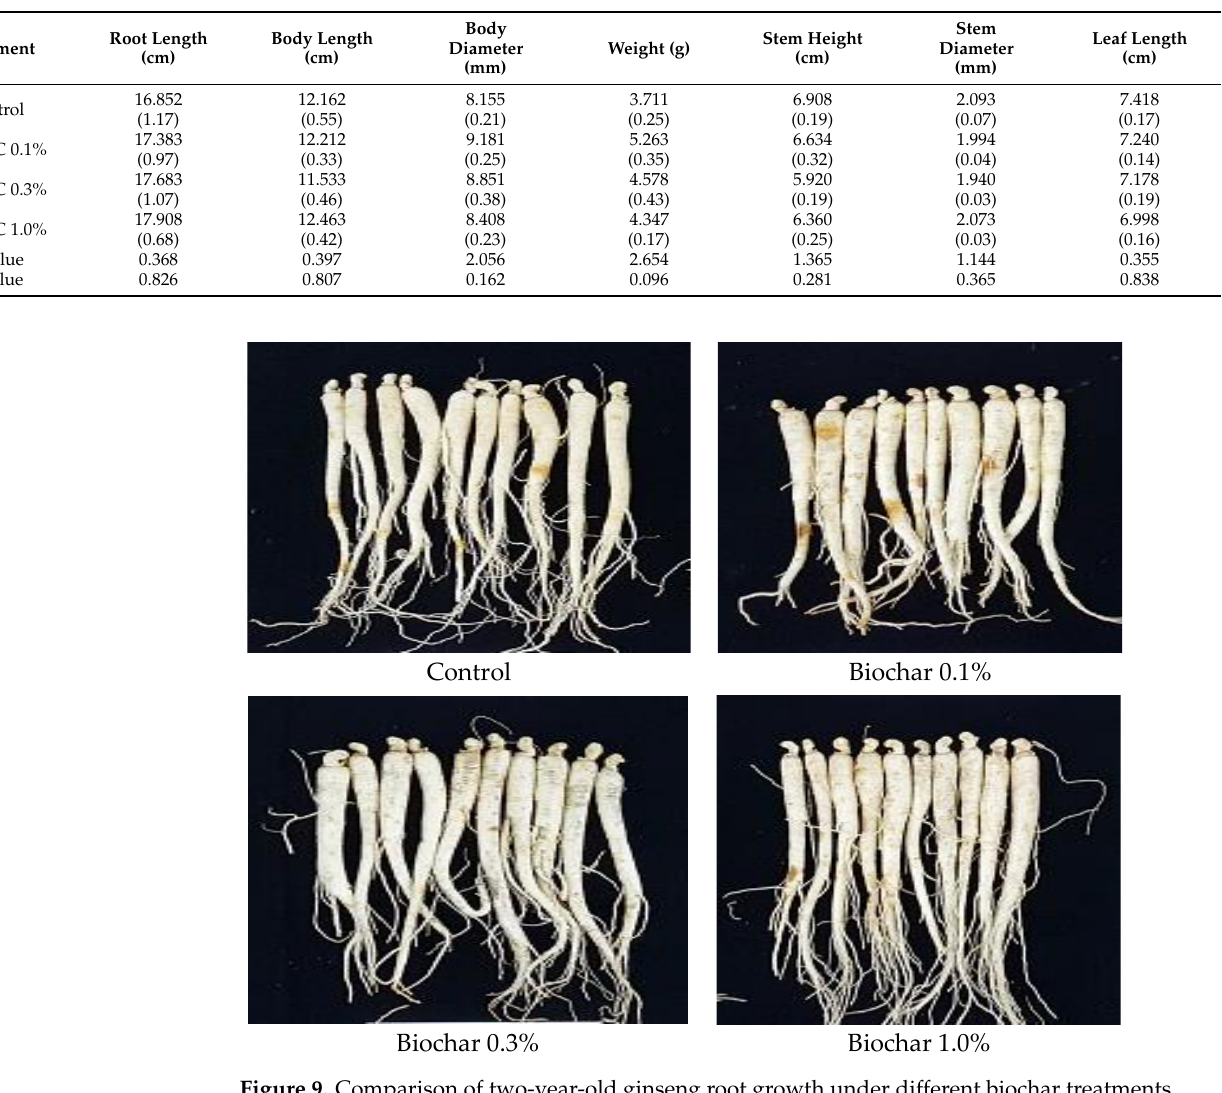
Figure 9. Comparison of two-year-old ginseng root growth under different biochar treatments Table 6. Comparison of ginseng quality evaluation by biochar treatment (average of each treatment with standard error).